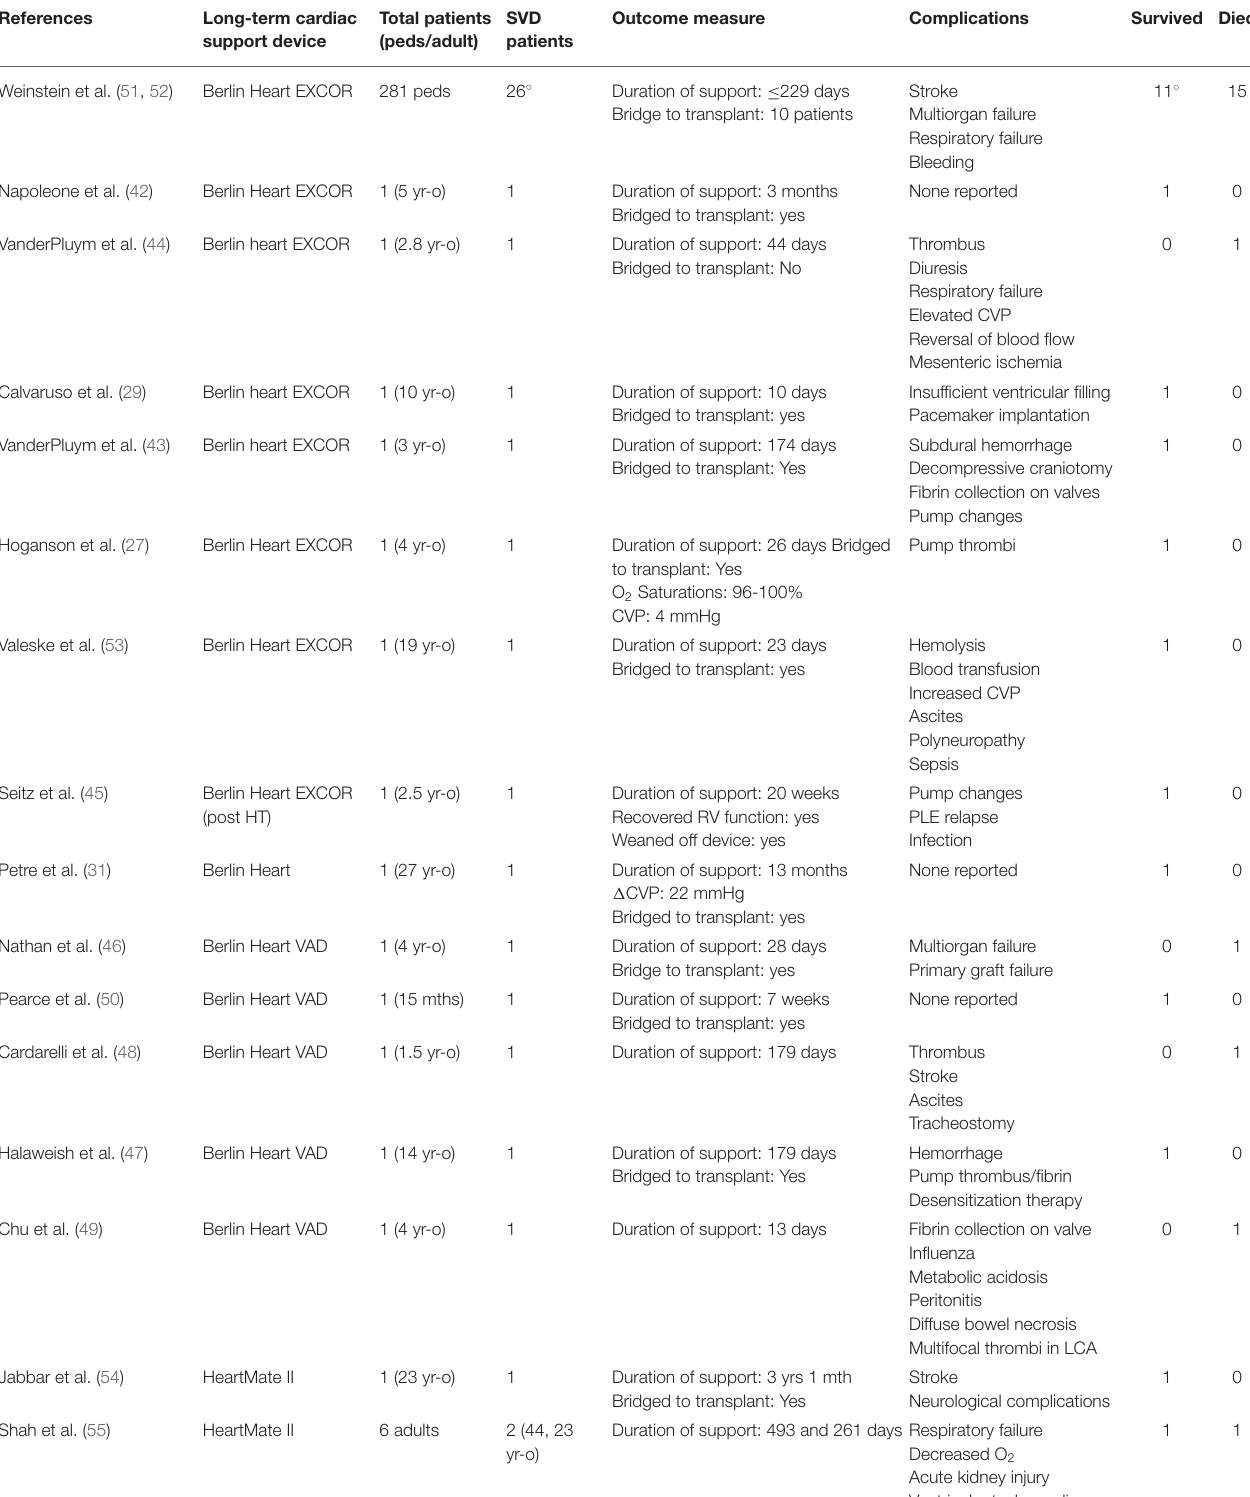
TABLE 1 | Comprehensive list of case studies and retrospective studies where long term, mechanical ventricular assist devices were implanted in patients, adult and pediatric, with a failed Fontan